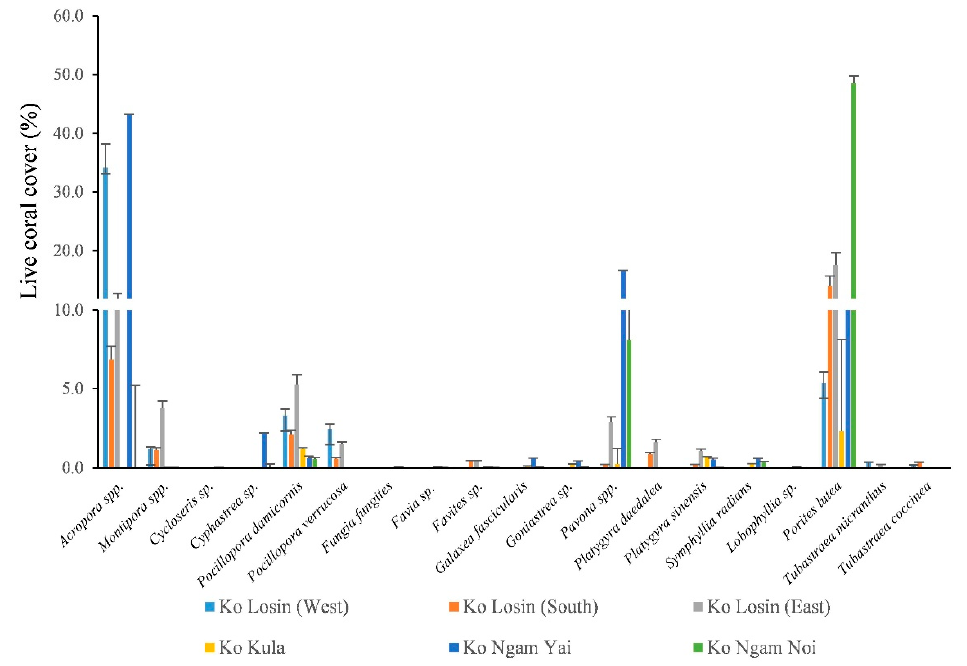
Figure 4. Species composition of corals at the study sites. Error bars indicate standard